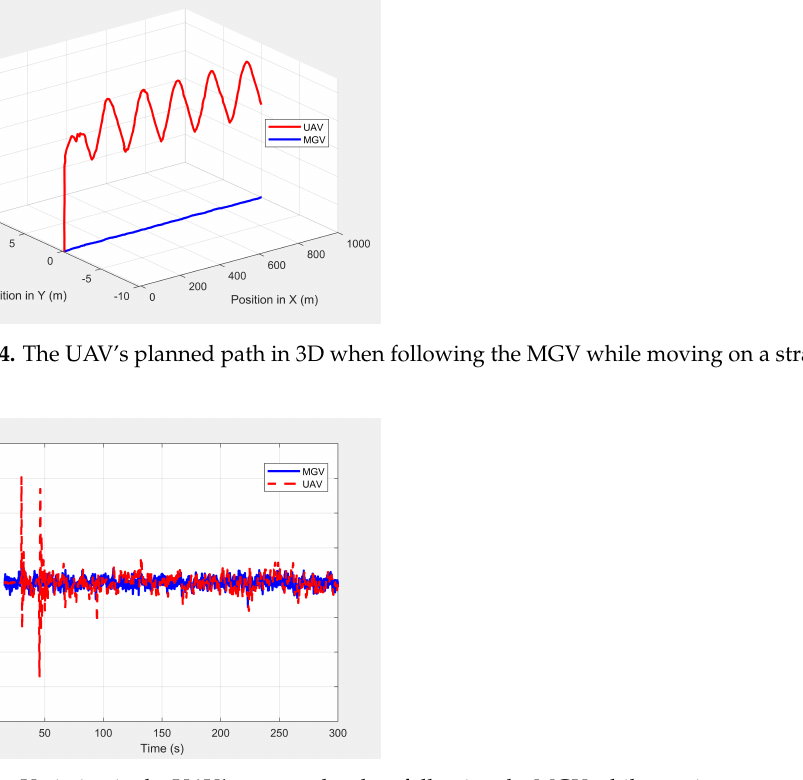
Figure 5. Variation in the UAV’s yaw angle when following the MGV while moving on a straight path. Figures 6 and 7 show the UAV look-ahead coverage and altitude variation,